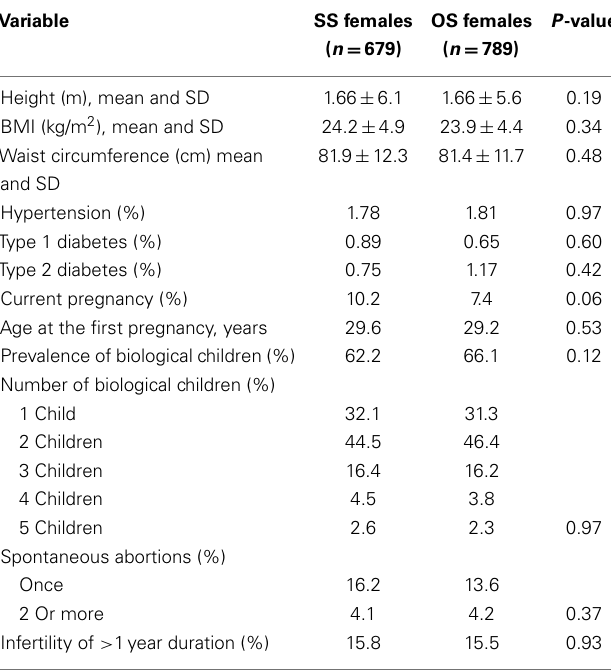
Table 1 | Obesity measures, disease status, and reproductive characteristics for females from same-sex (SS) and opposite-sex (OS) dizygotic twin